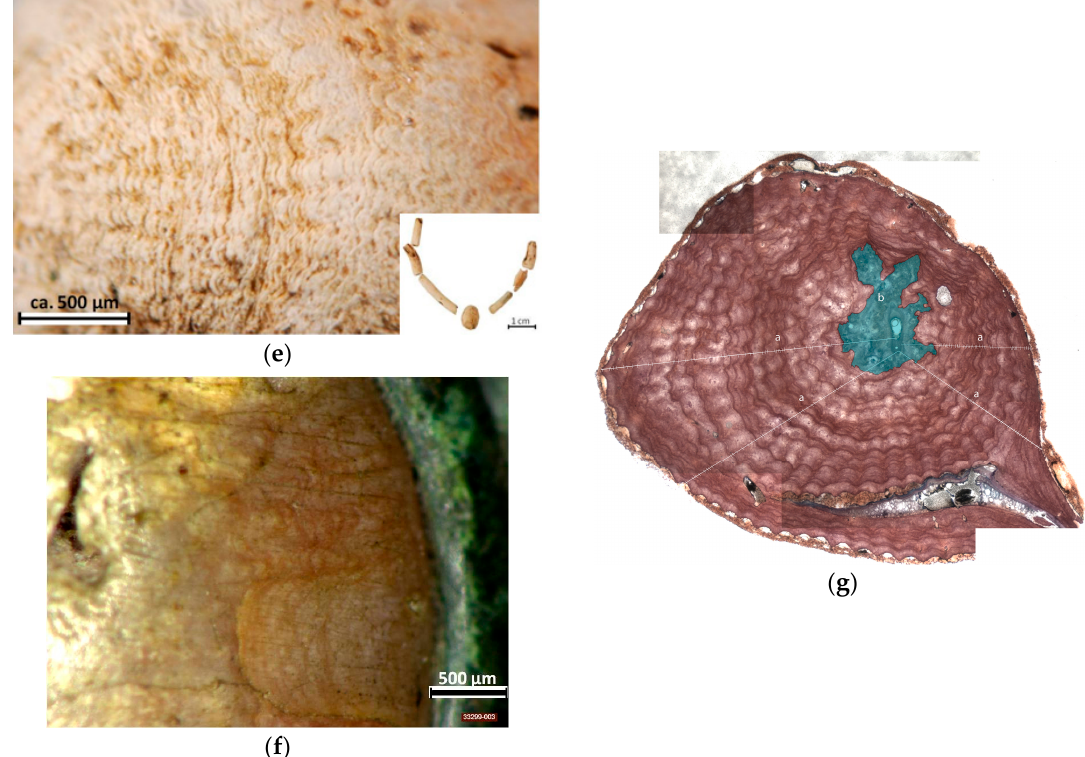
Figure 3. Surface structures of ancient corals and similarities with recent reference objects. ( a ) Inner side of three lamellae of a coral bead from a female grave in Ditzingen-Schöckingen (Landkreis Ludwigsburg). ( b ) Corallium rubrum from an area near Marseille with longitudinal crenulation covering the stem, resulting in a concentric, wavy structure in the cross section. ( c ) Belt chain from Bussy-le-Château (département Marne), showing three concentric features of more intense color than the pale center of the piece, indicating the medullar region of a cross-section of C. rubrum ; see (Figure 3g). ( d ) Recent C. rubrum from the Strait of Messina also showing parts of faded color. ( e ) Coral bead from Tomb 122 of the Magdalenenberg tumulus; detail of Figure 2a. ( f ) Detail of a partially red area of a C. rubrum piece from Somme-Tourbe “la Bouvandeau” in the Champagne. ( g ) Section of a Corallium rubrum colony after decalcification and staining [47,53].